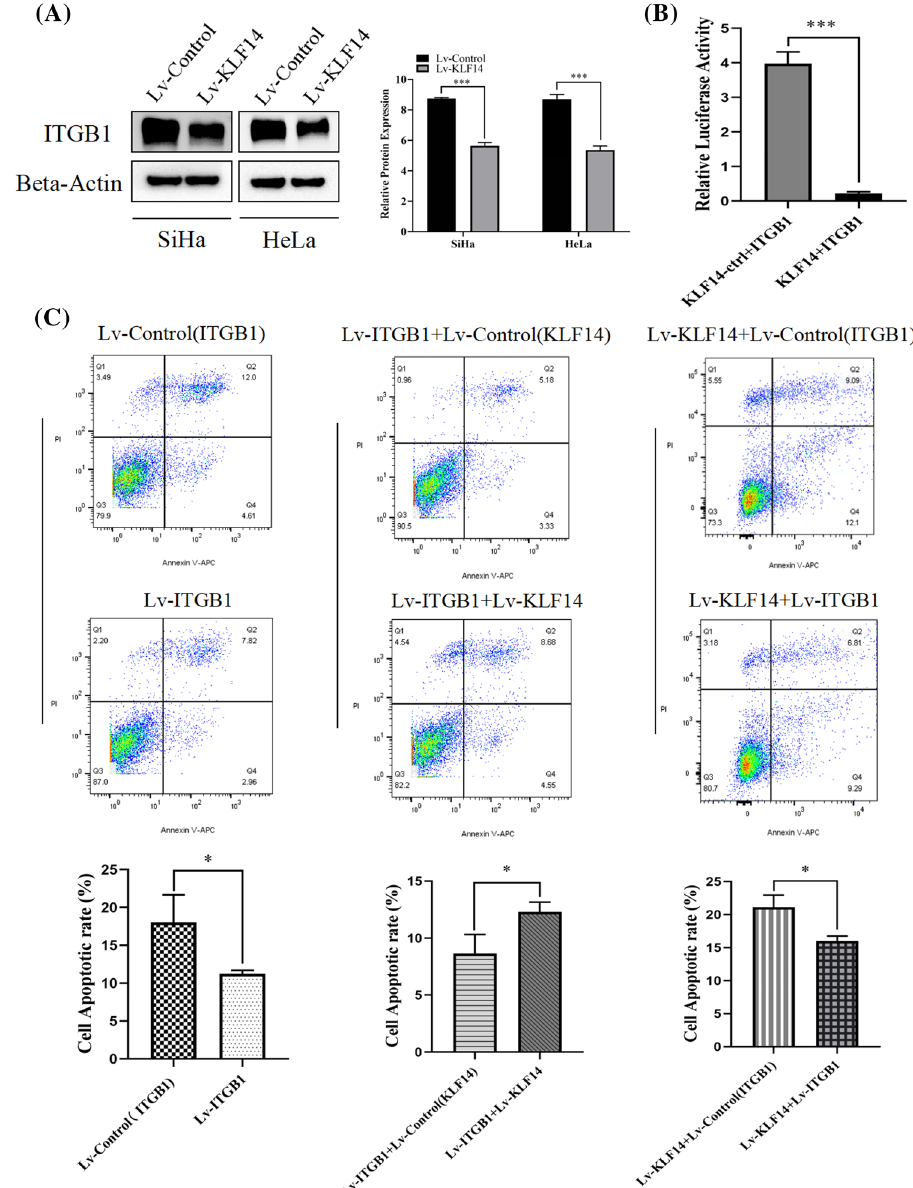
Fig. 5 KLF14 regulates ITGB1 and affects cervical cancer cell apoptosis. A The Western blot results showed that the ITGB1 expression level in the Lv-KLF14 group was lower than that in the Lv-control group. B The dual-luciferase reporter assay results showed that KLF14 directly targeted ITGB1 and downregulated ITGB1 expression. C